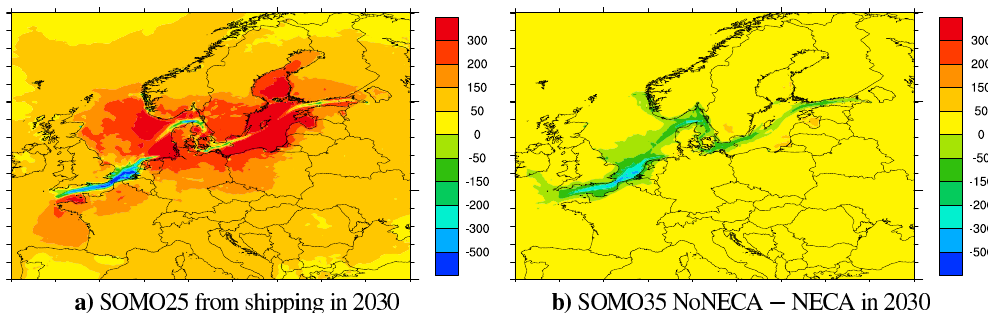
Figure 9. Year 2030 differences in SOMO35 in ppb days. Left, calculations as the 2030 model run without a NECA minus a model run excluding ship emissions in the Baltic Sea and the North Sea. Right, calculations as the 2030 model run without a NECA minus a model run with NECA